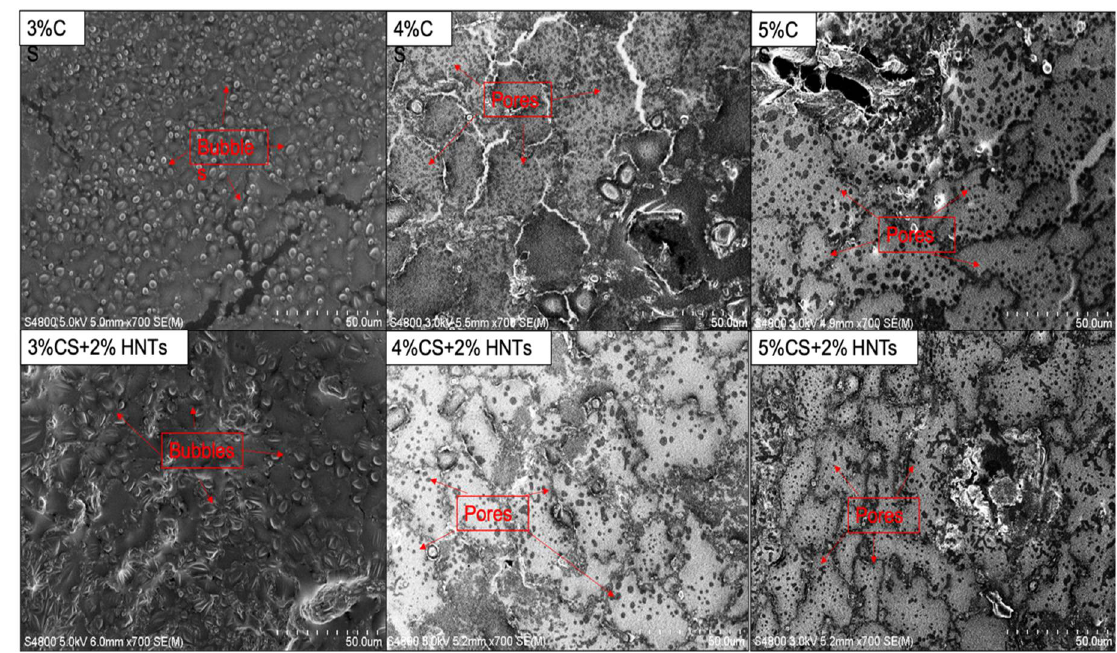
Figure 10. SEM images of cross-section for different hydrogel composites. The arrows in the picture of 3% chitosan (3%C) and its HNTs composites (3%CS + 2%HNTs) point to the example of bubbles. The arrows in the picture of 4% chitosan (4%C) and 5% chitosan (5%C) and their hydrogel composites (4%CS + 2%HNTs and 5%CS + 2%HNTs) point to the example of pores.